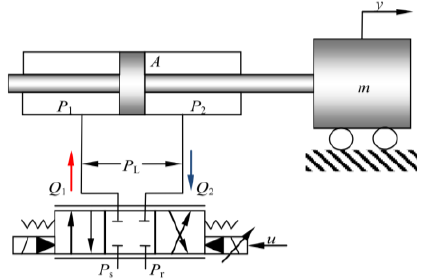
Figure 1. Schematic diagram of the hydraulic actuator system.